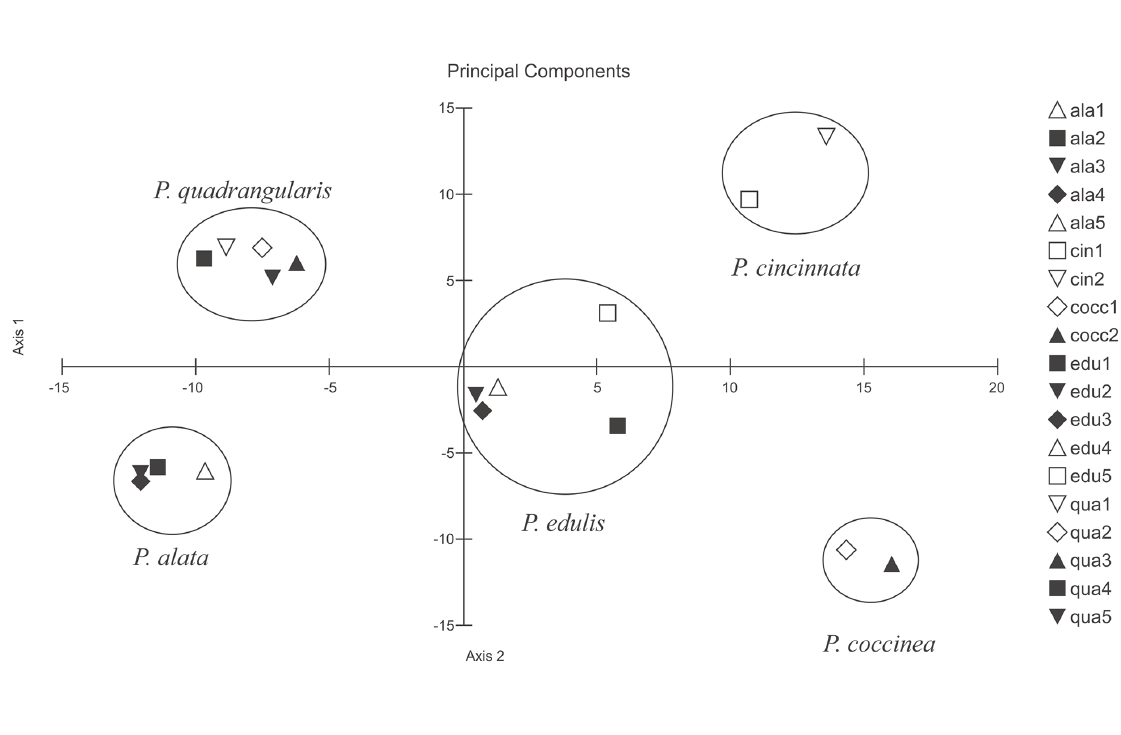
Figure 3 - Principal component analyses of floral scent of Passiflora based on volatile